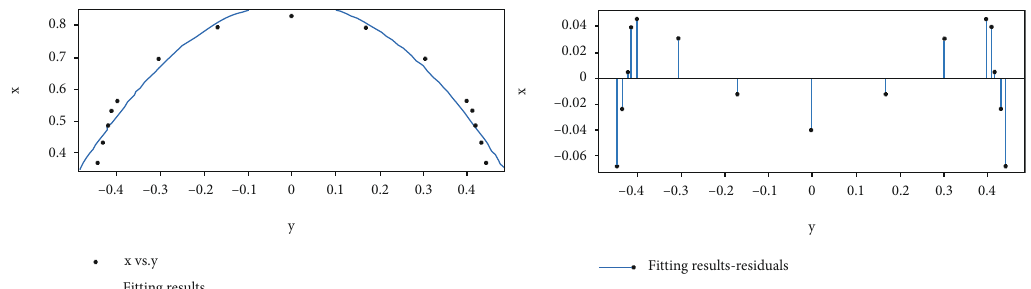
Figure 4: Fitting results of the reachable area under nominal conditions. (Note: x and y denote the normalized longitudinal and cross ranges, respectively).